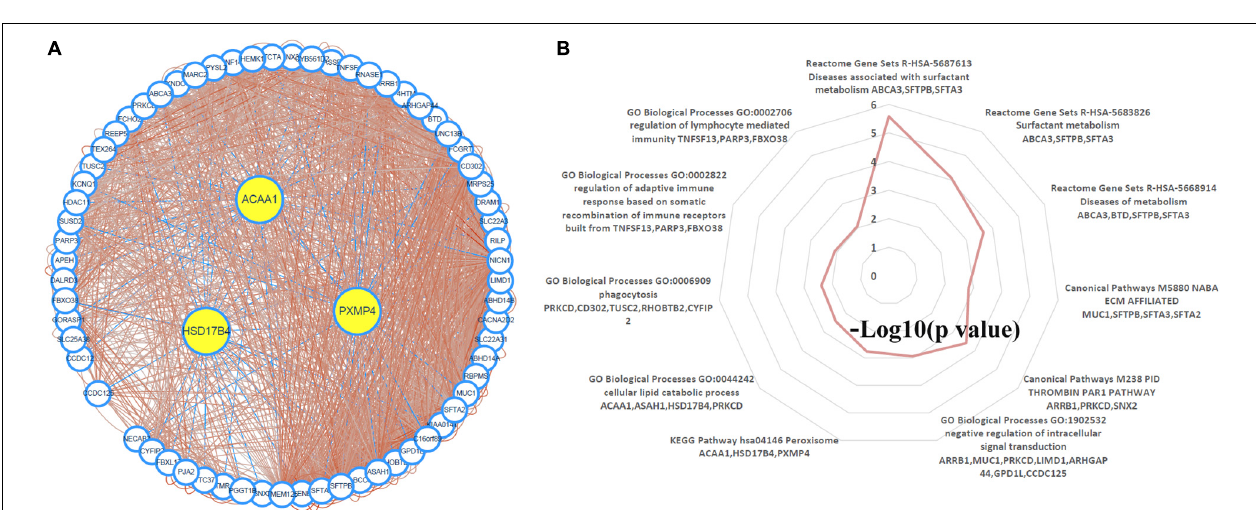
their copy number values in both LUSC and LUAD.